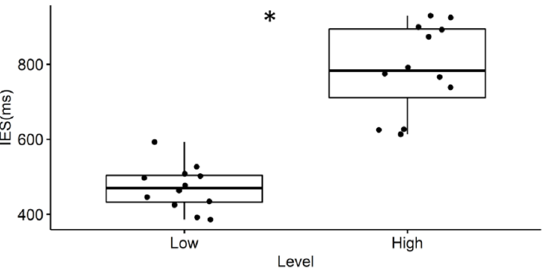
Figure 3. Results of Behavioral Measures. The higher the Inverse Efficiency Score (IES), the lower the performance of the subjects when a greater attentional demand is required. The asterisk (*) means p < 0.05.